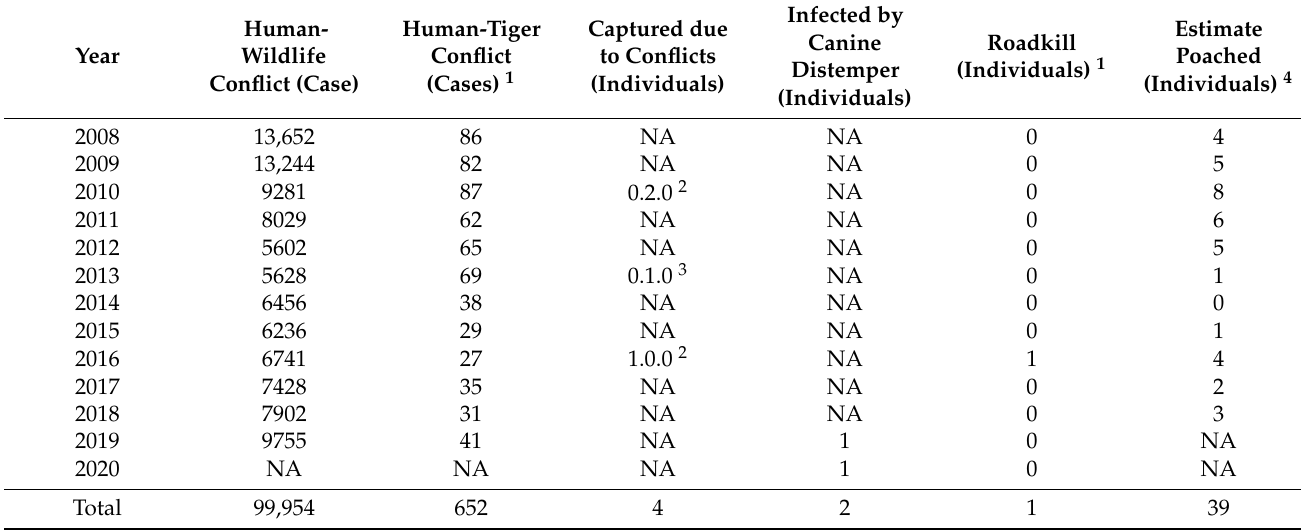
Table 2. Human–Tiger Conflicts in Malaysia 2008–2019.